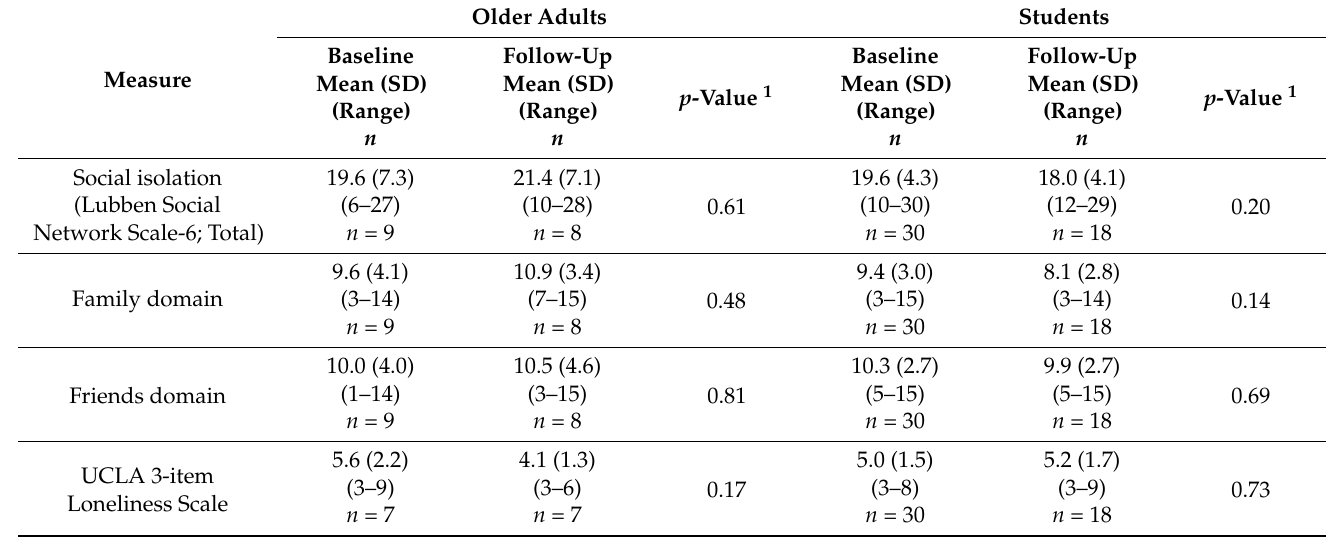
Table 1. Mean social network and loneliness scores among older adults and students participating